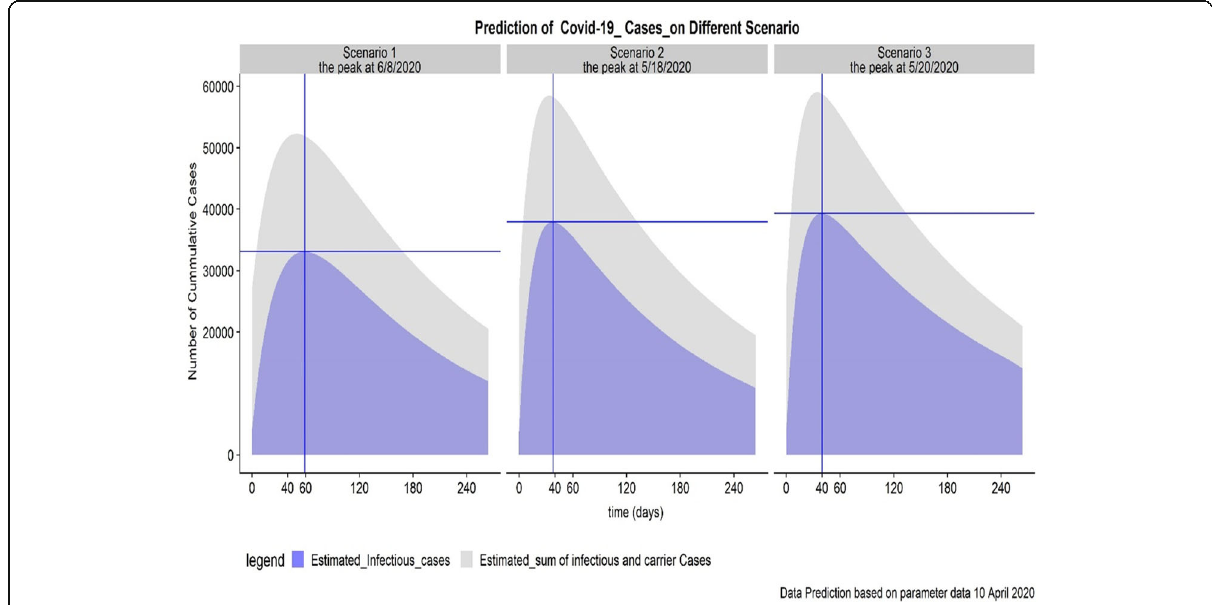
Fig. 4 Prediction of COVID-19 Cases on Different Scenario in